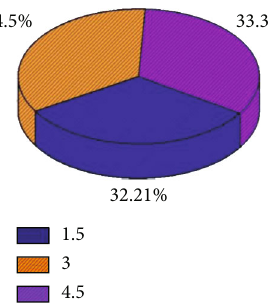
Figure 7: The contribution of silica fi ller in terms of weight percentages to fl exural